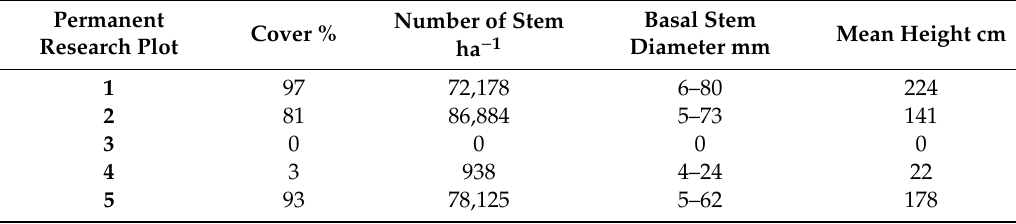
Table 5. Basic dendrometric characteristics of pontic rhododendron on permanent research